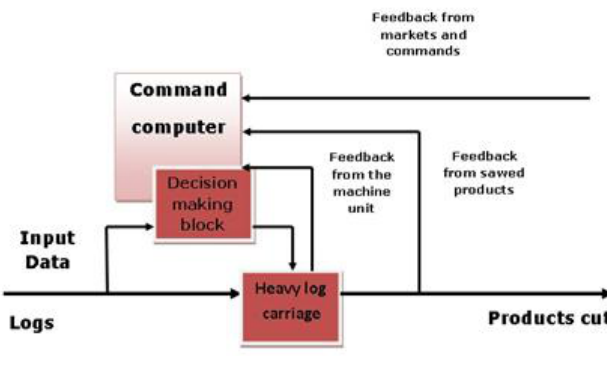
Figure 5. The command principle of the